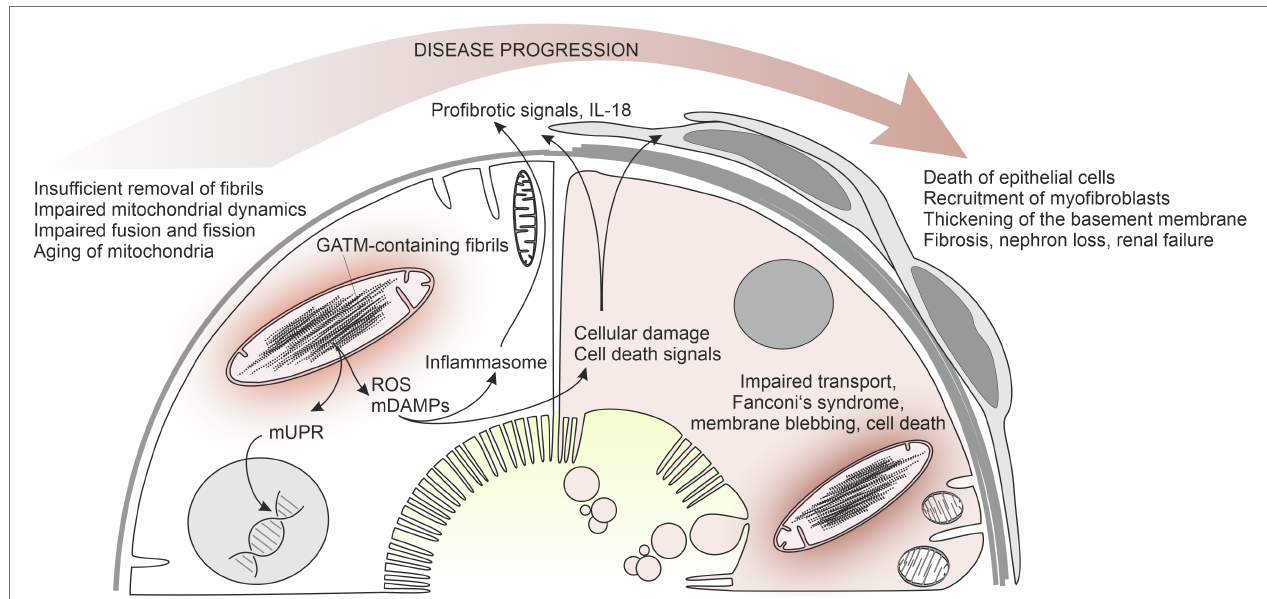
FIGURE 2 | Working hypothesis of the pathophysiology of mutant GATM-induced Fanconi’s syndrome with kidney failure. An early state of the disease is shown on the left, a later state on the right. Mutated GATM forms fibrillary structures within the mitochondrial matrix that cannot be degraded. In LLC-PK1 cells, these large pathological mitochondria are associated with increased ROS production, increased NLRP3 expression, strongly increased IL-18 production, and increased mRNA for fibronectin and alpha smooth muscle actin (Reichold et al., 2018). Presumably, release of mitochondrial danger-associated molecular patterns (mDAMPs) underlies the activation of the inflammasome. Moreover, mitochondrial unfolded protein response possibly occurs leading to transcriptional changes. The persistent mitochondrial fibrils impair mitochondrial dynamics, fusion, and fission of mitochondria and result in mitochondrial aging and enhanced cell death (right side of the model). Profibrotic mediators, such as IL-18, and factors released from dying cells activate interstitial cells and myofibroblasts are recruited. In our patients with end-stage renal disease, proximal tubules are almost absent and have been replaced by scar